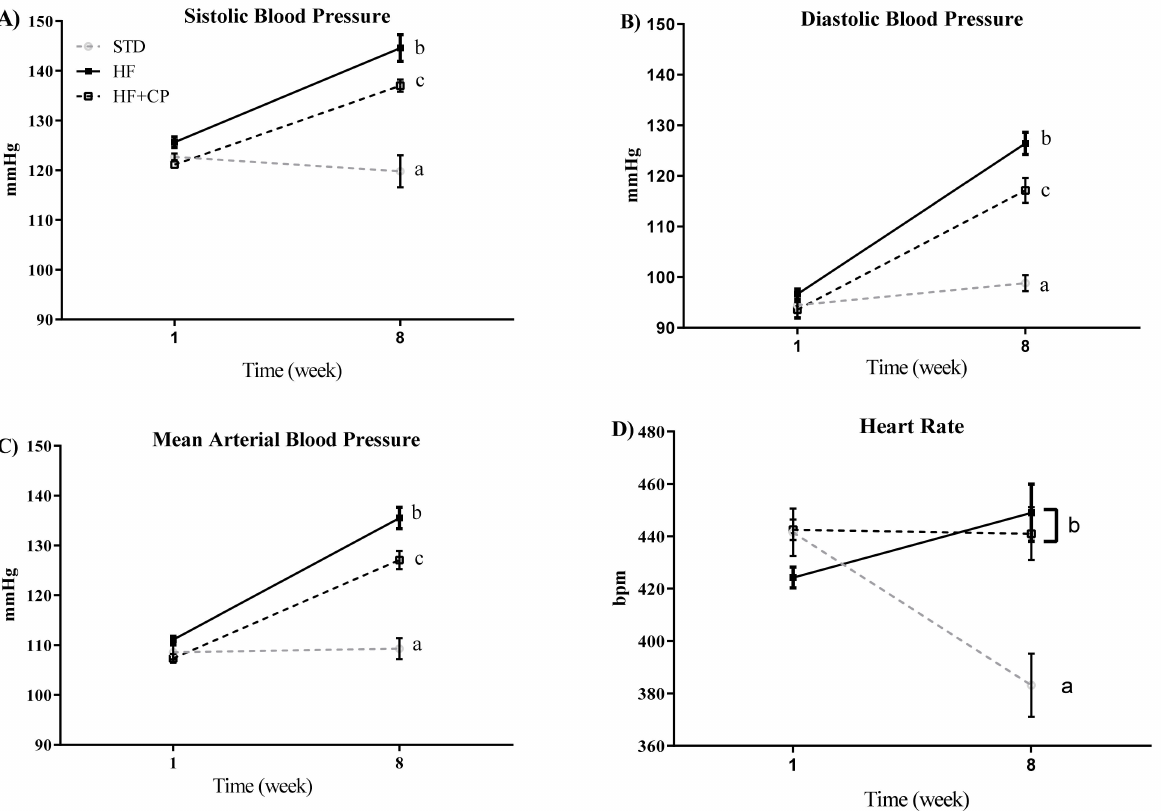
Figure 3. Effect of cocoa protein on blood pressure and heart rate in an obesity-induced by diet rat model. ( A ) Systolic blood pressure (SBP), ( B ) diastolic blood pressure (DBP), ( C ) mean blood pressure (MBP), and ( D ) heart rate (HR) measured by tail-cuff plethysmography at times 0 and 8 weeks. Values are expressed as mean ± SEM ( n = 7 per group). a,b,c significantly different from STD, HF and HF + CP groups, respectively ( p <